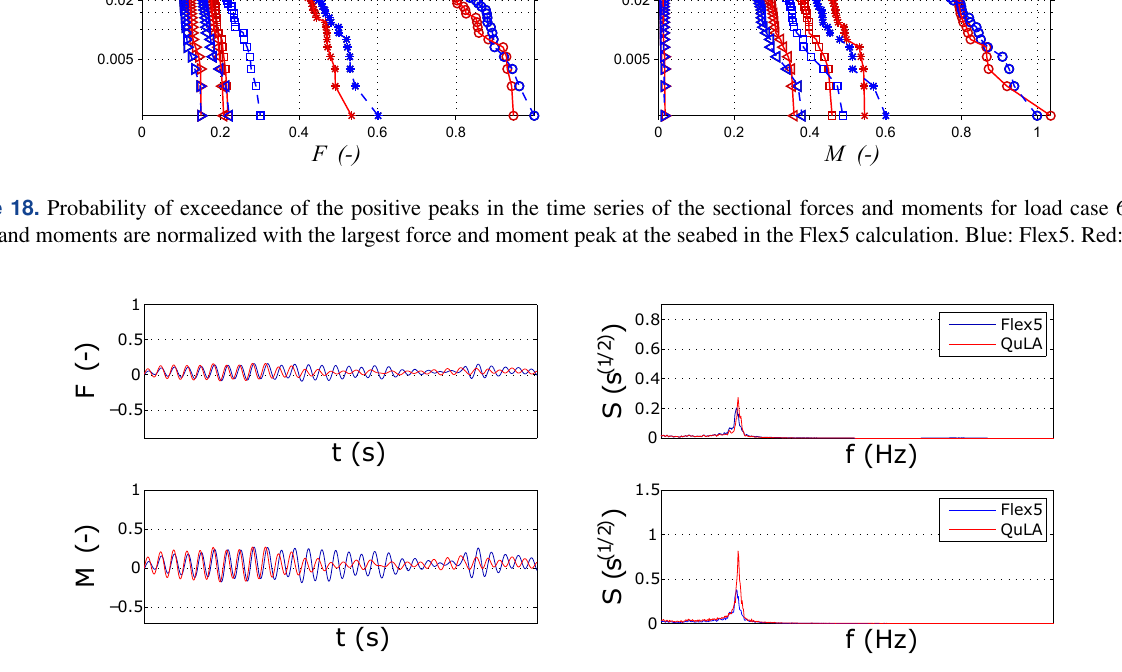
Figure 19. Sectional force and moment 26m above the SWL for load case 6.1. The force and moment time series are normalized with the largest force and moment at the seabed in the Flex5 calculations.